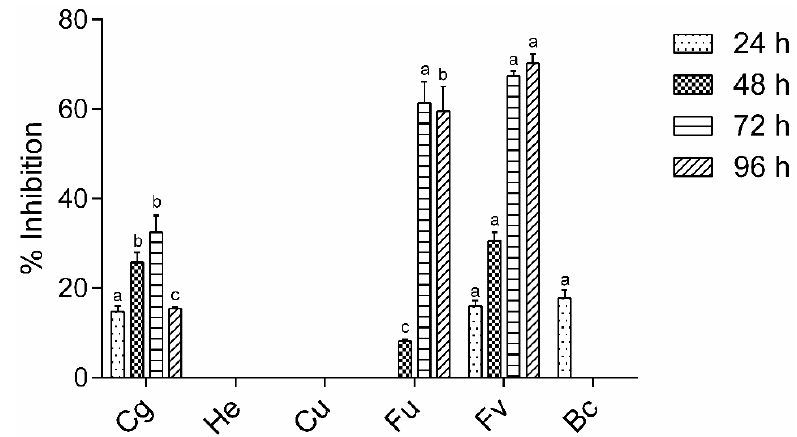
Figure 4. Antifungal inhibition (%) of NO’s clean biopolymer (2.24 mg/mL) against Colletotrichum. gloeosporioides ( Cg ), Helminthosporium sp. (He); Curvularia sp. ( Cu ); Fusarium sp. (Fu); Fusarium. verticillioides (Fv), and Botrytis. cinerea (Bc). Data are shown as mean ± SE (n = 2). Means with different letters are significantly different according to ANOVA and the Tukey test ( p < 0.05). Comparisons between strains were performed for each time.